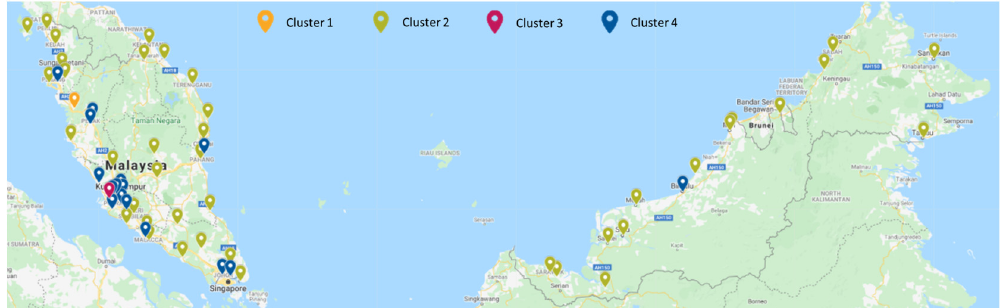
Figure 20. Air monitoring stations’ locations colored according to clusters for PM 10 daily maximum time series data with DTW and agglomerative hierarchical as its clustering algorithm.